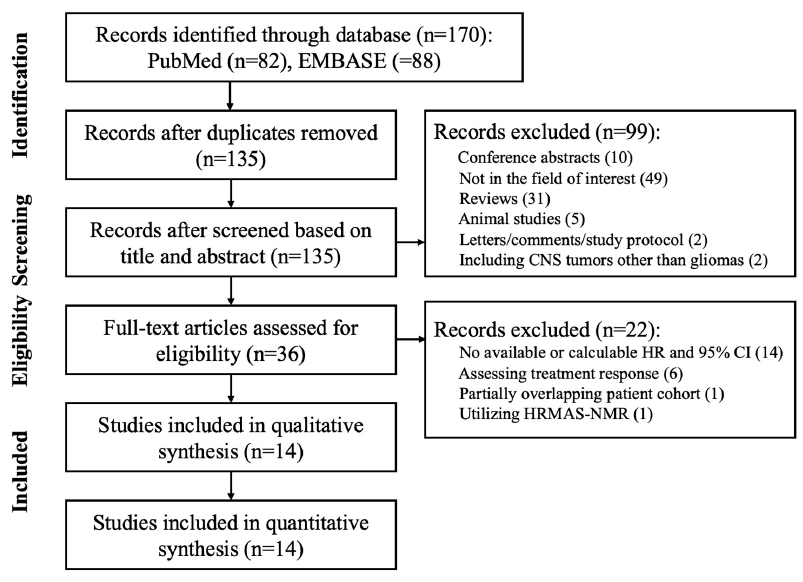
Figure 1. Flow diagram of the study process .